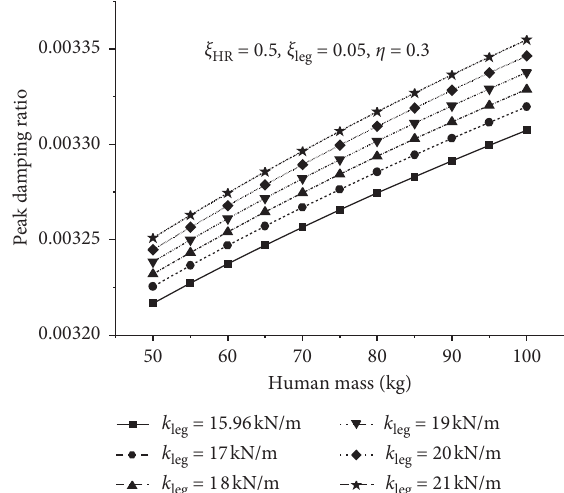
Figure 30: Normalized GRF under different leg stiffness.